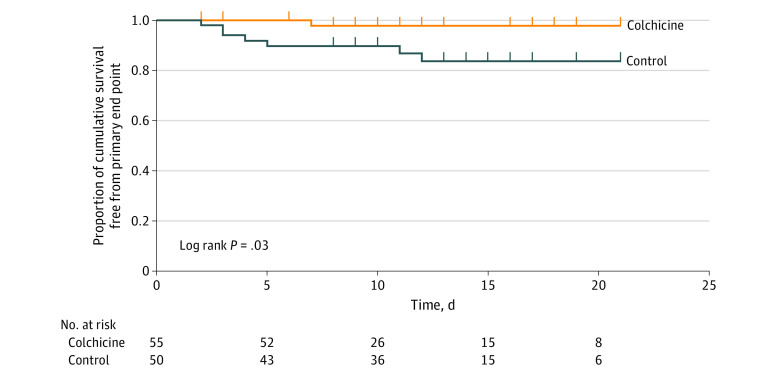
Kaplan-Meier Curves for Survival From the Primary Clinical End Point